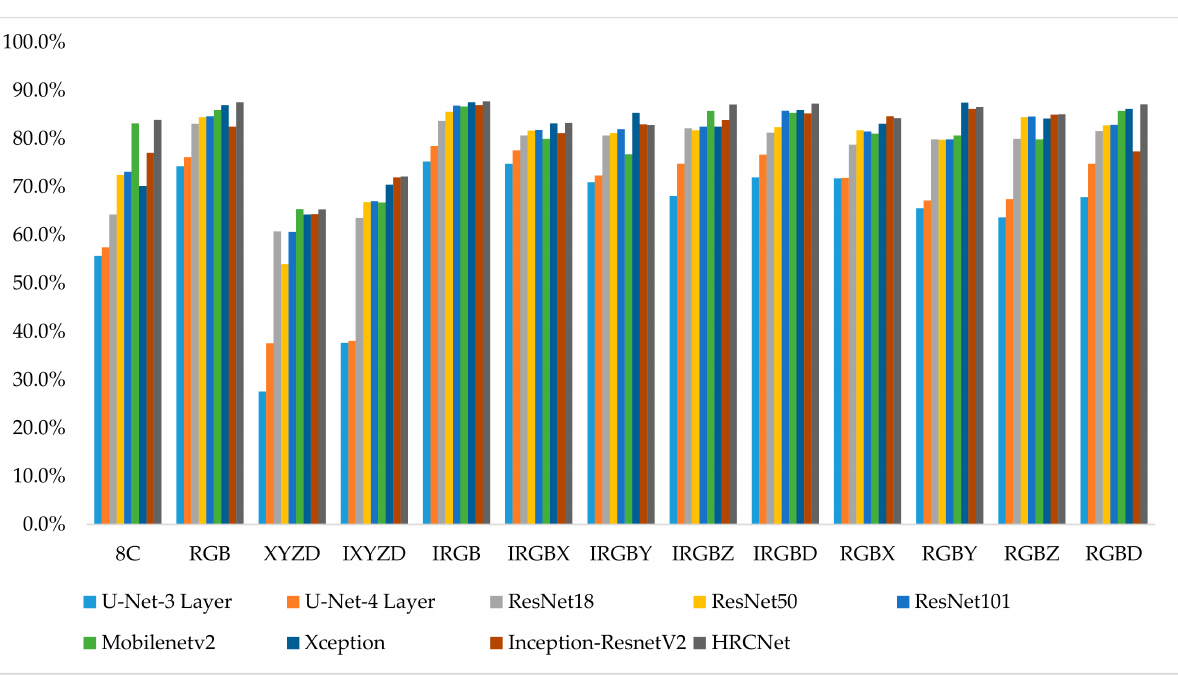
Figure 4. Overall accuracy (OA) on test point